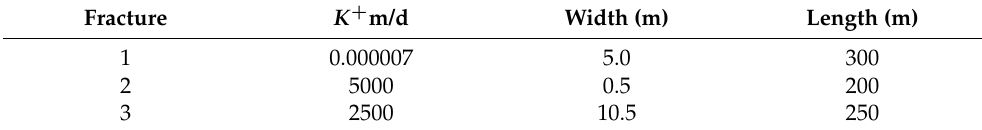
Table 1. Described parameters for Figure 4.